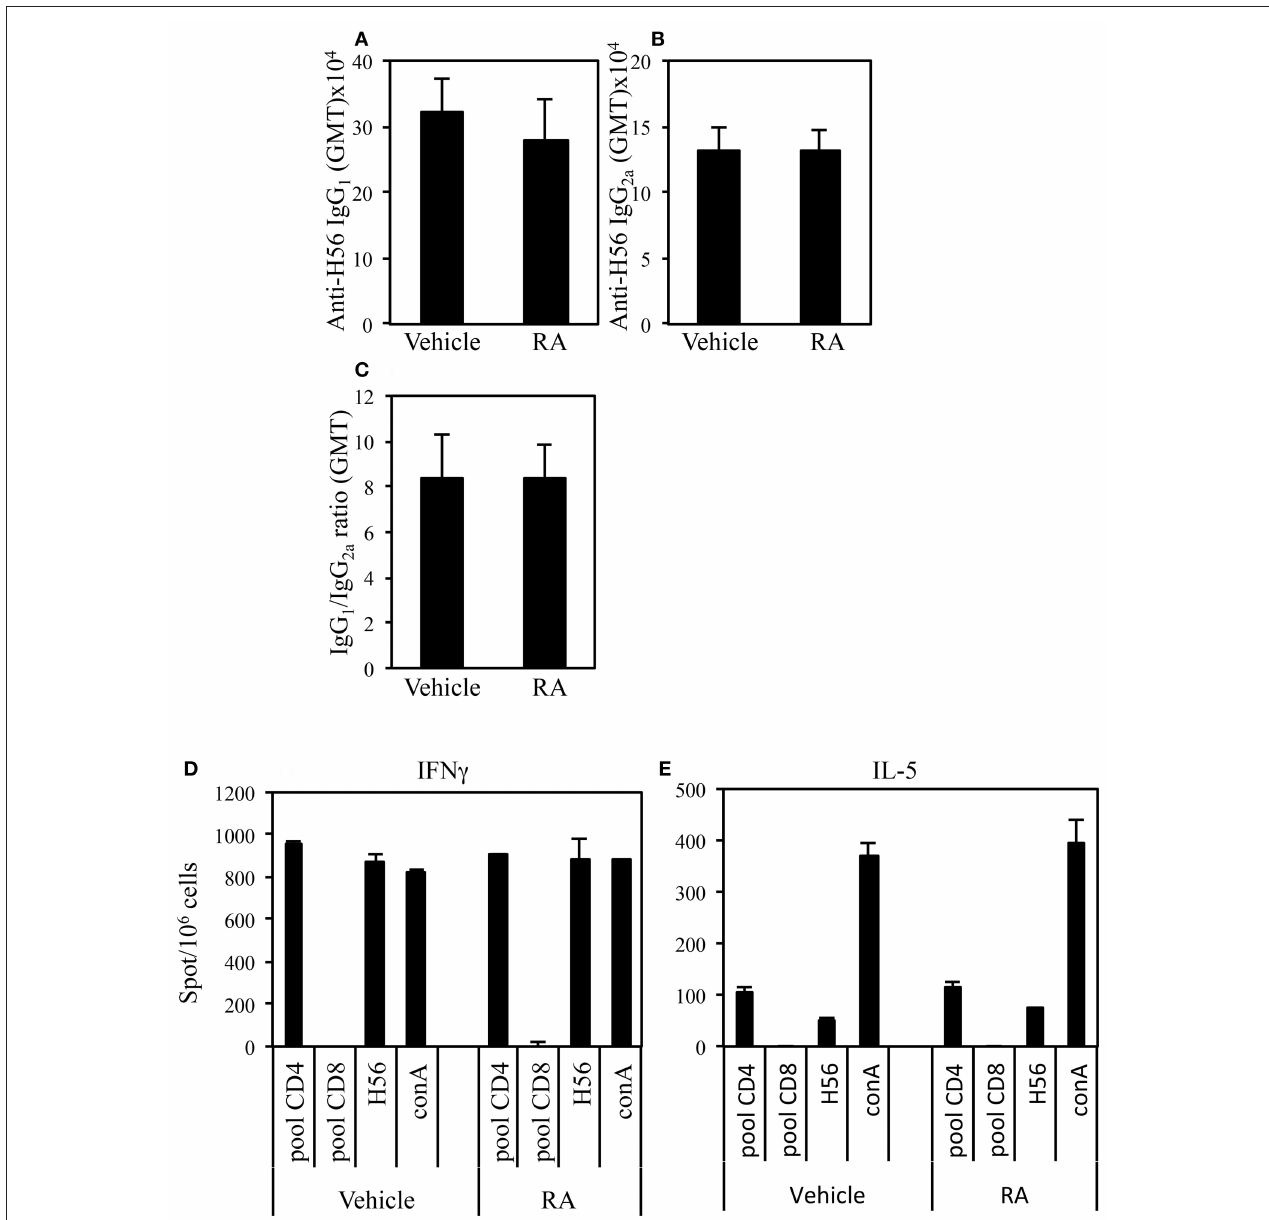
FIGURE 2 | Serum levels of Ag-specific IgG1 (A) and IgG2a (B) antibodies from CB6F1 mice treated or untreated with RA (300, 200, and 100 µ g/dose) or its vehicle (sesame oil) and immunized with CAF01 (125 µ g/dose) and H56 (0.5 µ g/dose). Values are indicated with geometric mean titer (GMT). (C) indicates the ratio between IgG1 and IgG2a titer. Bars indicate SEM. Ag-specific IFN γ (D) and IL-5 (E) responses measured in cells from peripheral blood by ELISPOT. Results are expressed in number of spots per 10 6 of cells of CB6F1 mice treated or untreated with RA or its vehicle and immunized with CAF01 (125 µ g/dose) and H56 (0.5 µ g/dose). Bars indicate